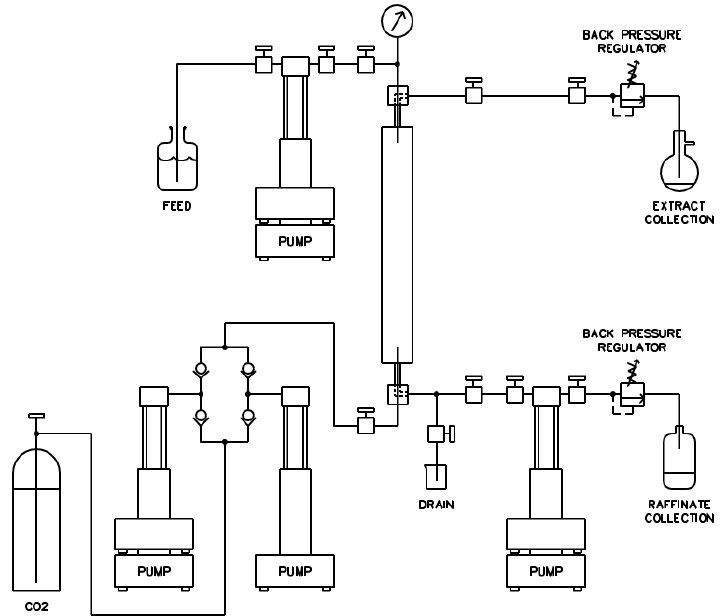
Figure 5. A schematic of CO 2 counter-current fractionation system for recovery of butanol.